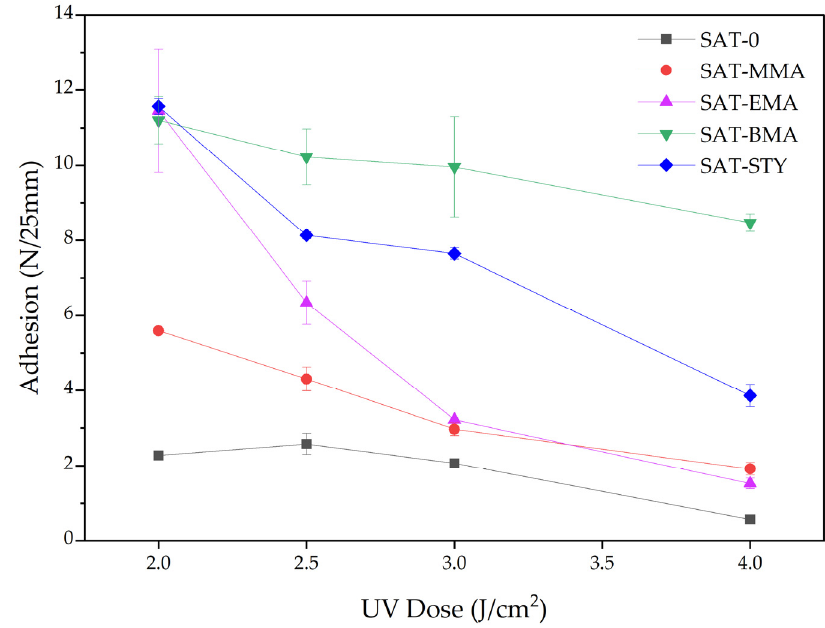
Figure 7. Adhesion to steel of UV-crosslinked SATs.